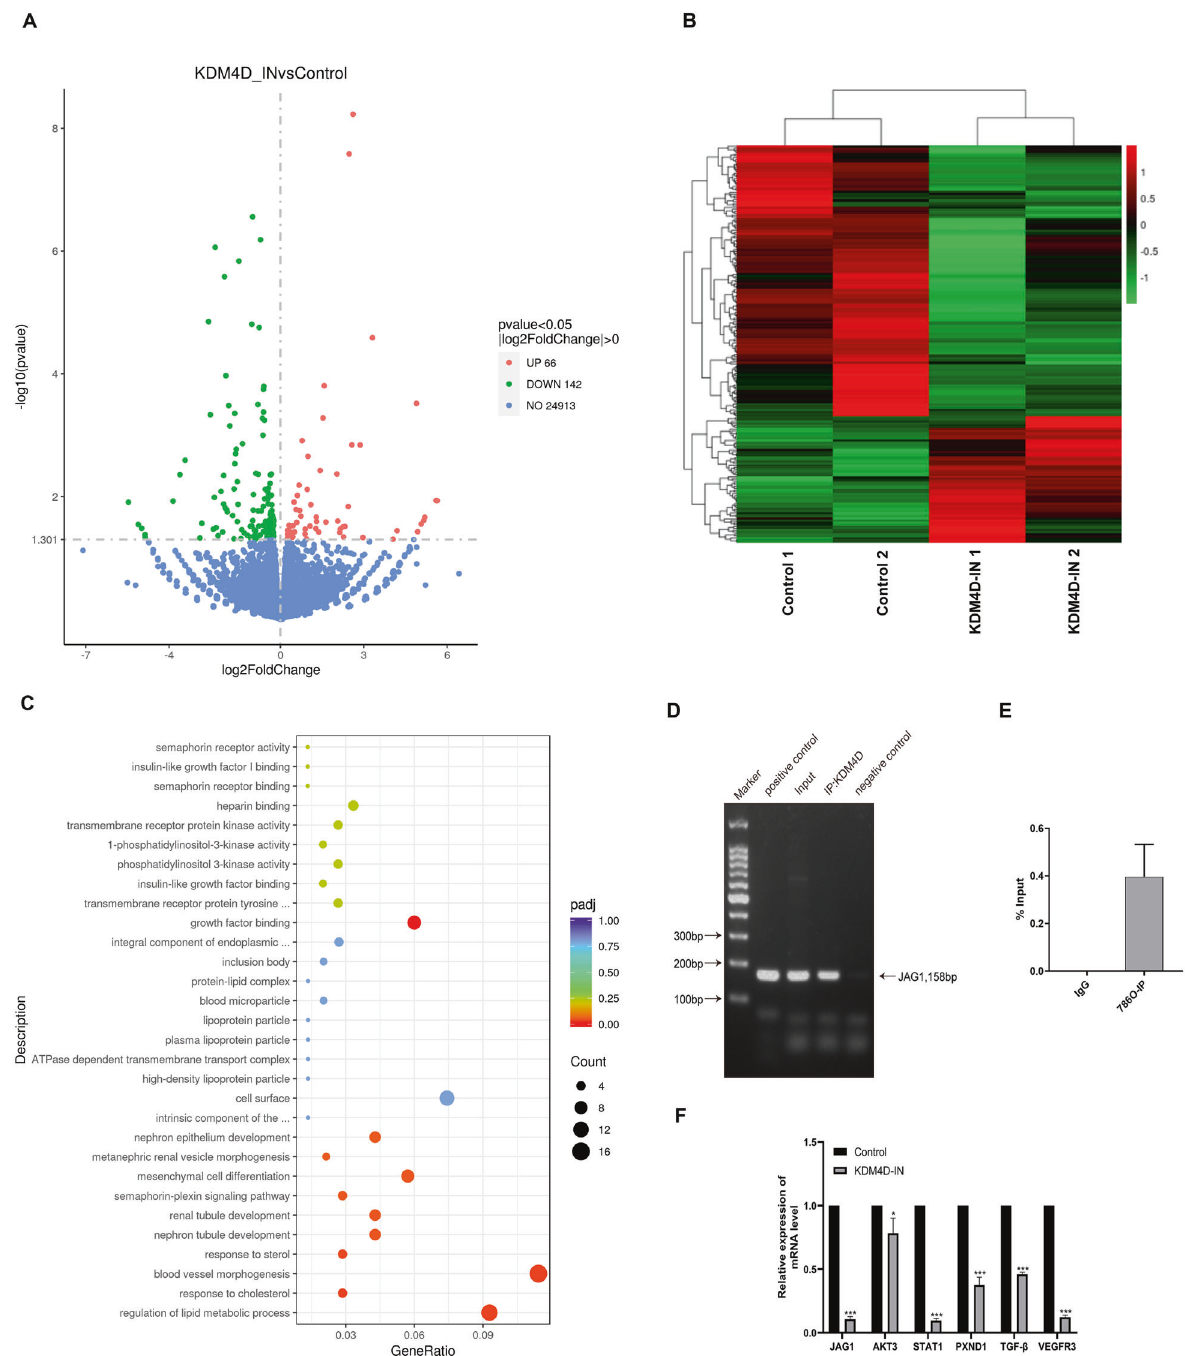
Fig. 4 KDM4D promotes ccRCC development by transcriptionally activating JAG1. A Volcano map of the upregulated and downregulated genes. B Differentially expressed genes in renal cancer cells treated with or without KDM4D inhibitor are displayed by heat map. C